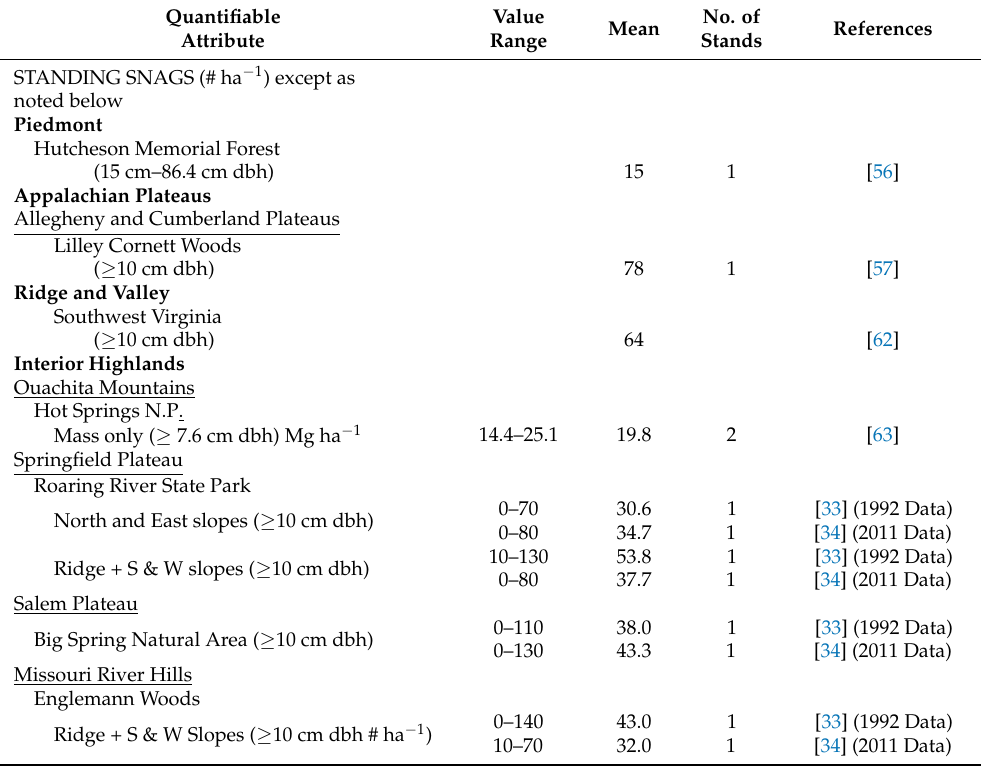
Table 6. Standing snags (# ha − 1 ) of representative dry-mesic old-growth oak forests. Quantifiable Attribute